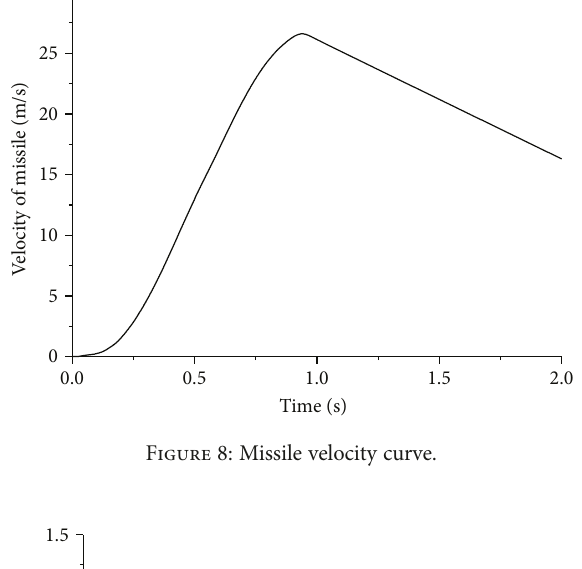
Figure 10: Vibration velocity of the launch canister